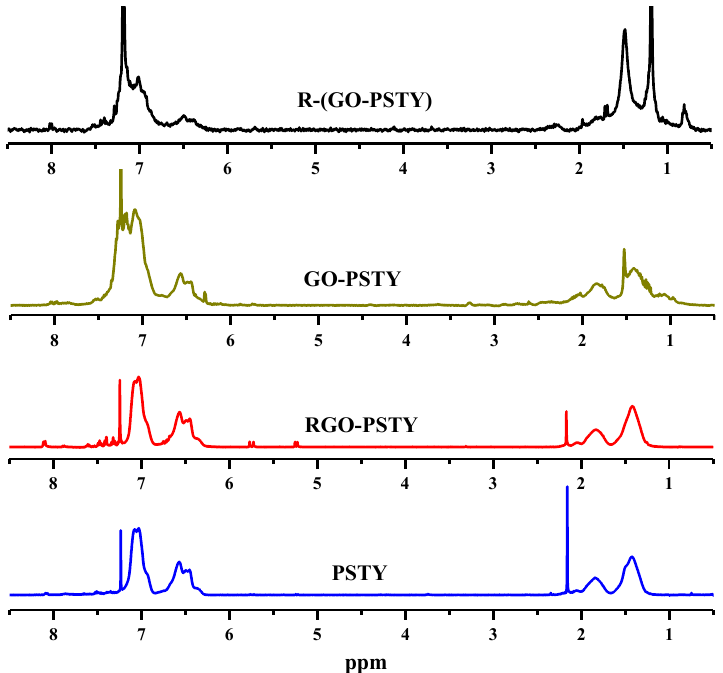
Figure 2. 1 H-NMR spectra of neat PSTY and all of the composites prepared from in situ bulk polymerization and microwave irradiation